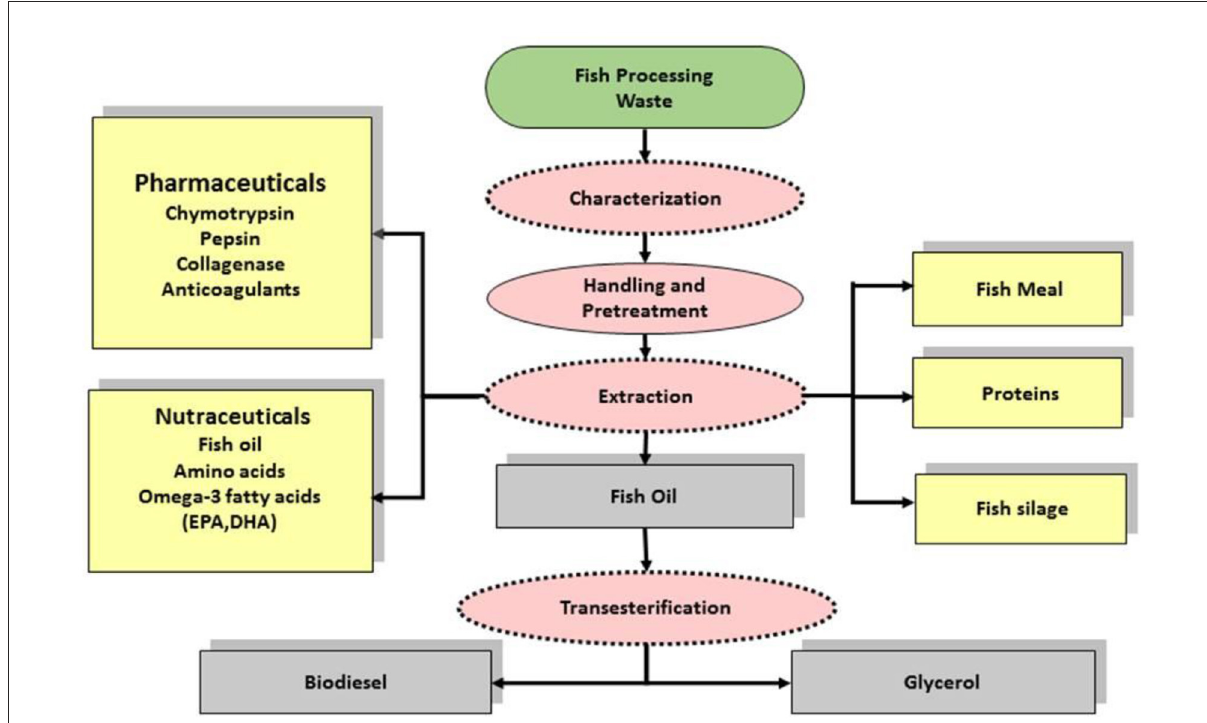
FIGURE4 Schematic diagram for finfish waste bio-refinery. Source: Vegneshwaran and Dave (125), with permission.